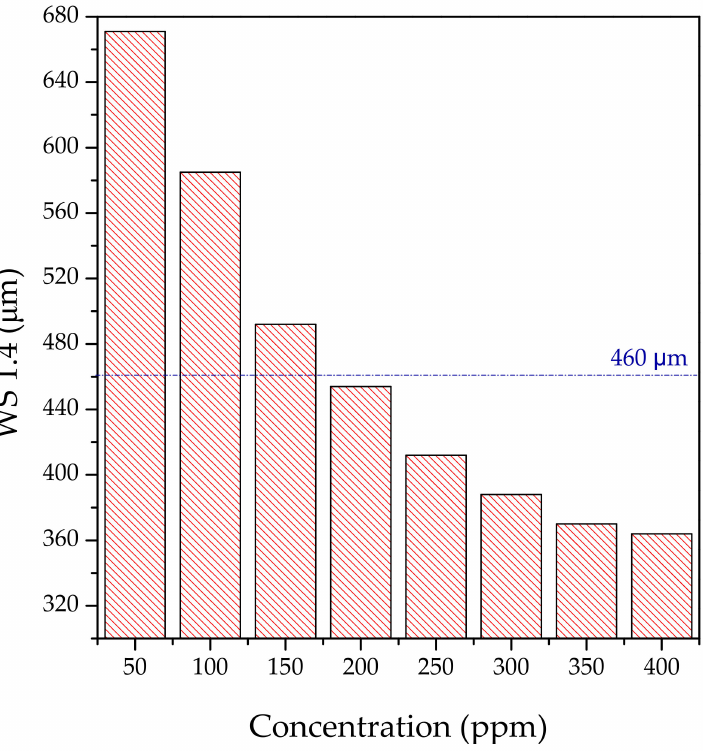
Figure 4. Impact of olive oil N , N -Bis(2-ethoxyethyl) amides addition on the lubrication characteristics of the base